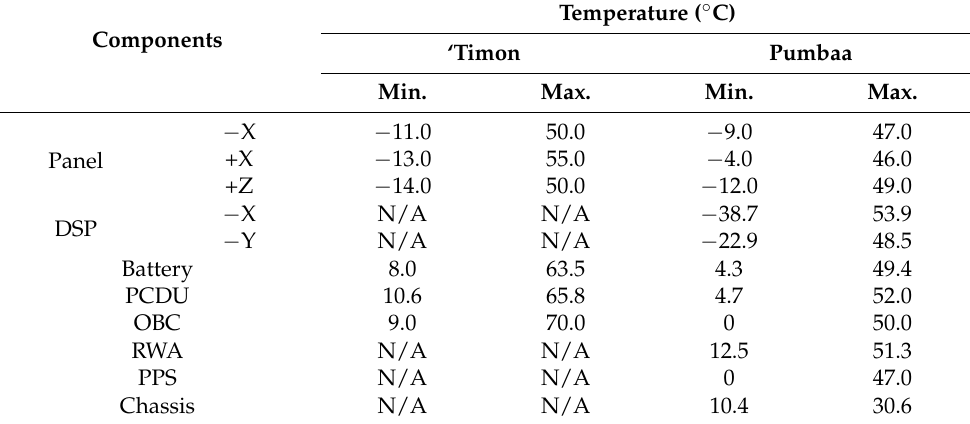
Table 9. TVCT results.